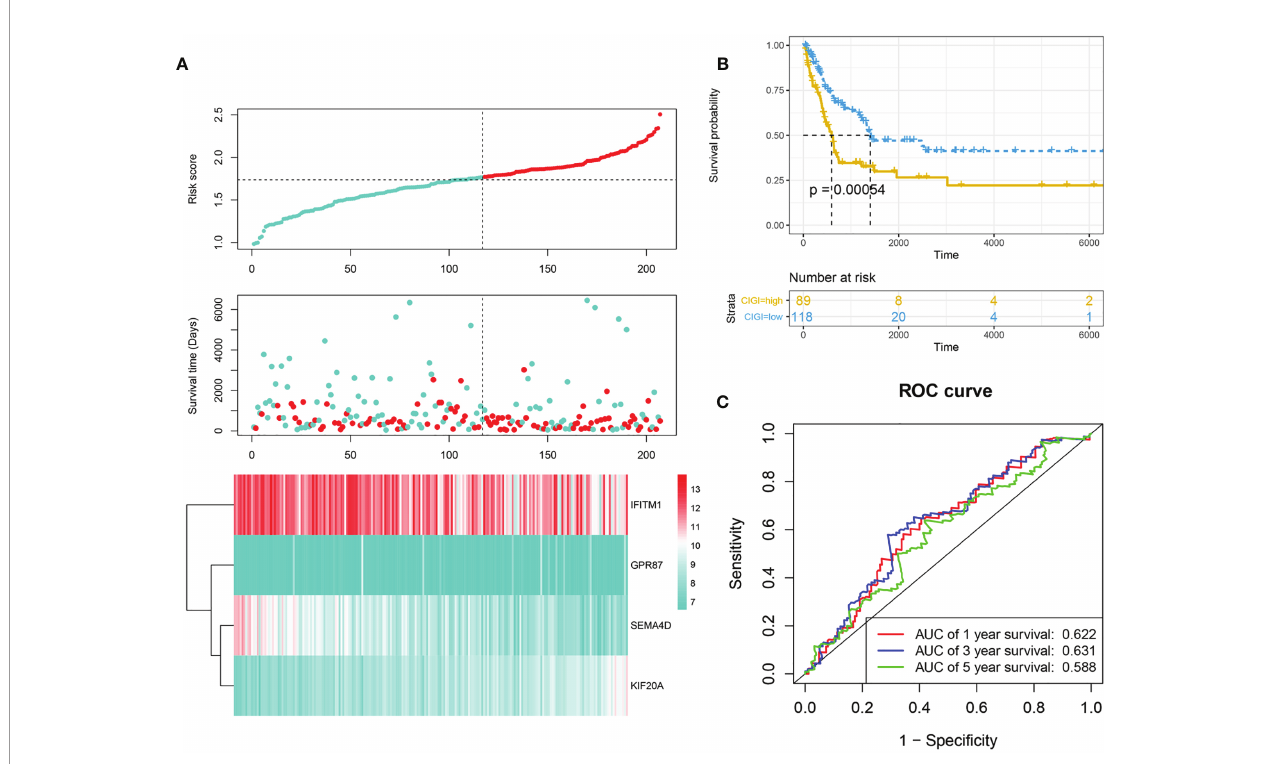
FIGURE 3 | Validation of CIGI in the GSE65904 dataset. (A) Risk scores, survival times, survival status and expressions of the six genes. (B) Kaplan – Meier analysis of the OS in the high- versus low-CIGI group of the TCGA cohort. (C) Time-dependent ROC analysis of CIGI for OS and survival